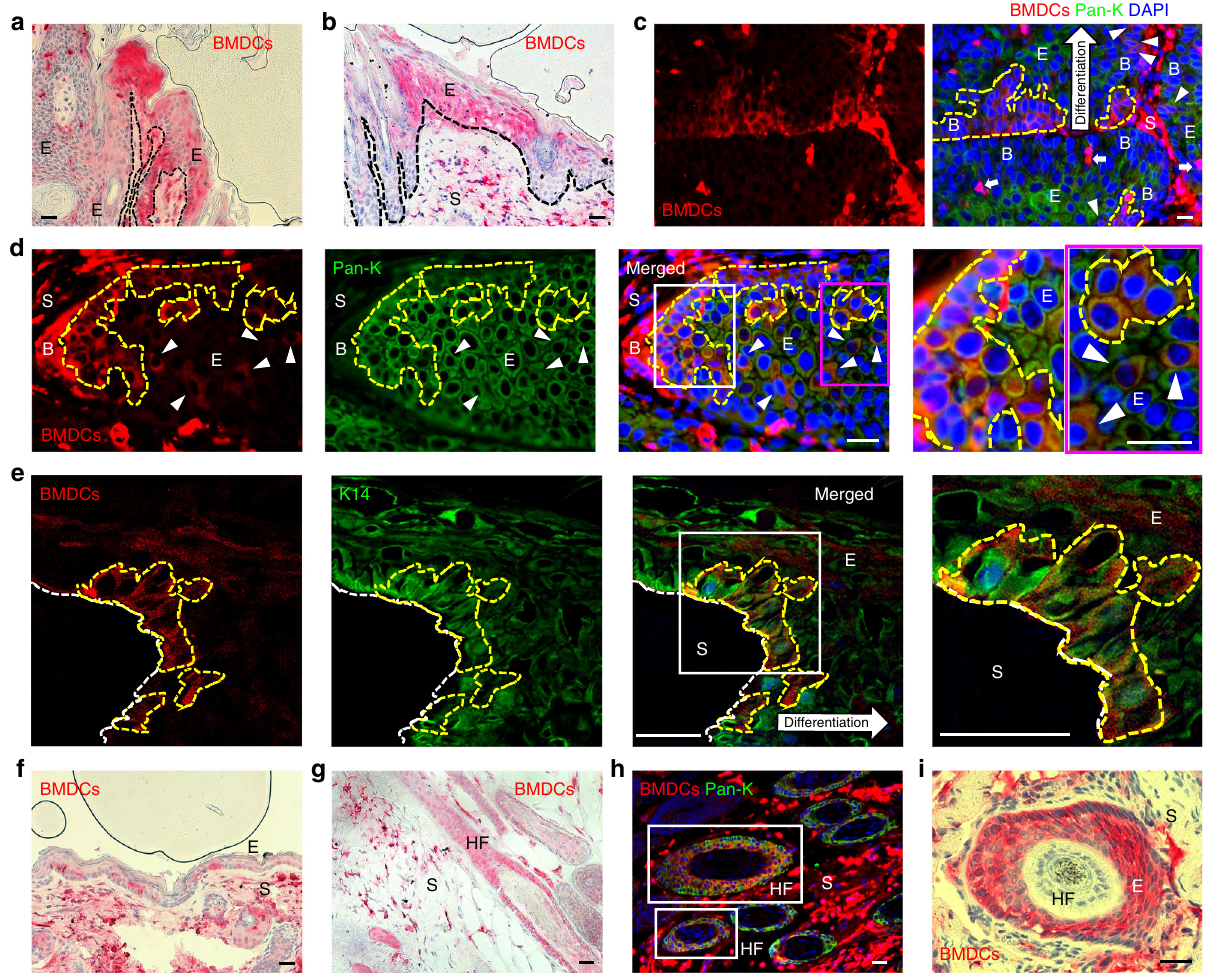
Fig. 3 Keratin-expressing BMDCs are in the basal layer of the papilloma epithelium. a , b GFP-positive BMDCs (red) were detected in the a papilloma epithelium and b junctional area of papilloma and adjacent hyperplastic epidermis in paraf fi n sections of a papilloma. c , d Groups of pan-keratin-positive BMDCs (areas of yellow broken line and white arrowheads) were detected in basal parts of the papilloma epithelium in paraf fi n sections (keratin-negative BMDCs: white arrows). Areas in white and magenta box in fi gure d are magni fi ed. e A group of K14-positive BMDCs (areas of yellow broken line) were detected in basal epithelium of frozen papilloma section (40 µ m) using a multiphoton confocal microscope (note: tumor stroma was washed out in the staining processes). Area in white box is magni fi ed. f , g BMDCs were detected in tumor-adjacent f hyperplastic epidermis, and g hair follicles. h Pan- keratin-positive BMDCs were identi fi ed in HFs (white boxes) under the tumor mass. i BMDCs were identi fi ed in deregulated HF structure under the tumor mass. *Black and white scale bars, 50 µ